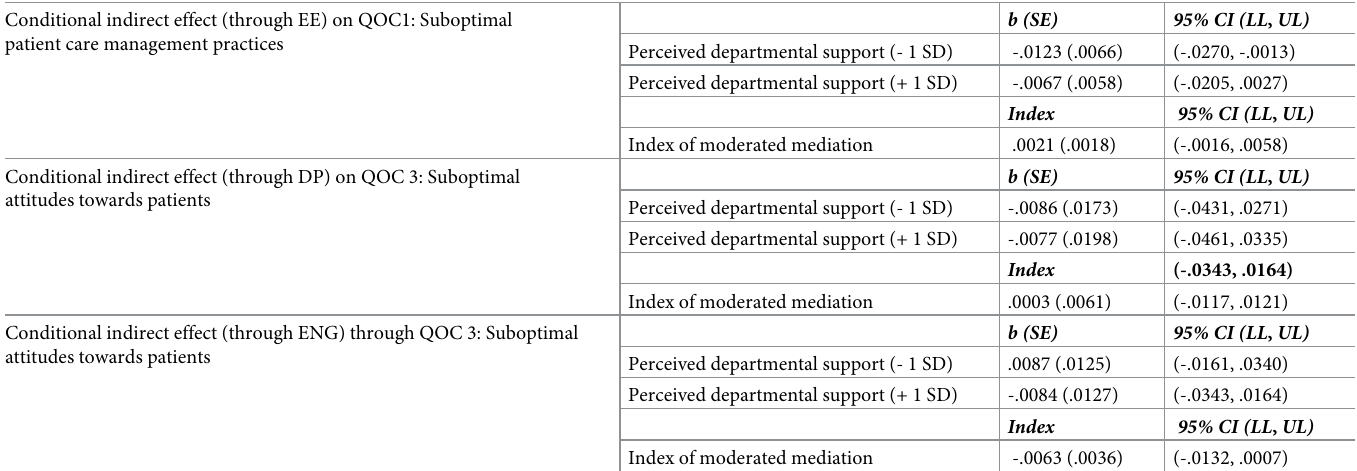
Table 3. Moderated indirect